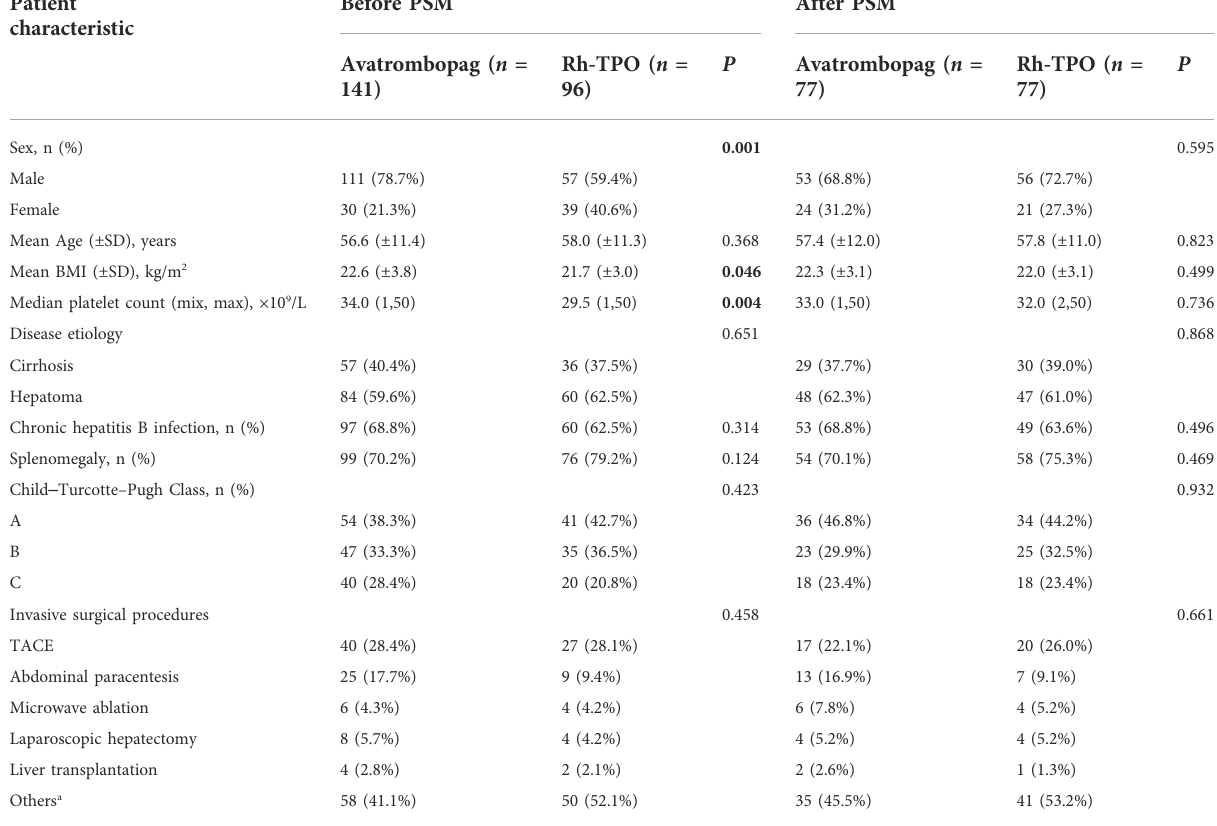
TABLE 1 Baseline characteristics before and after propensity score matching (PSM).